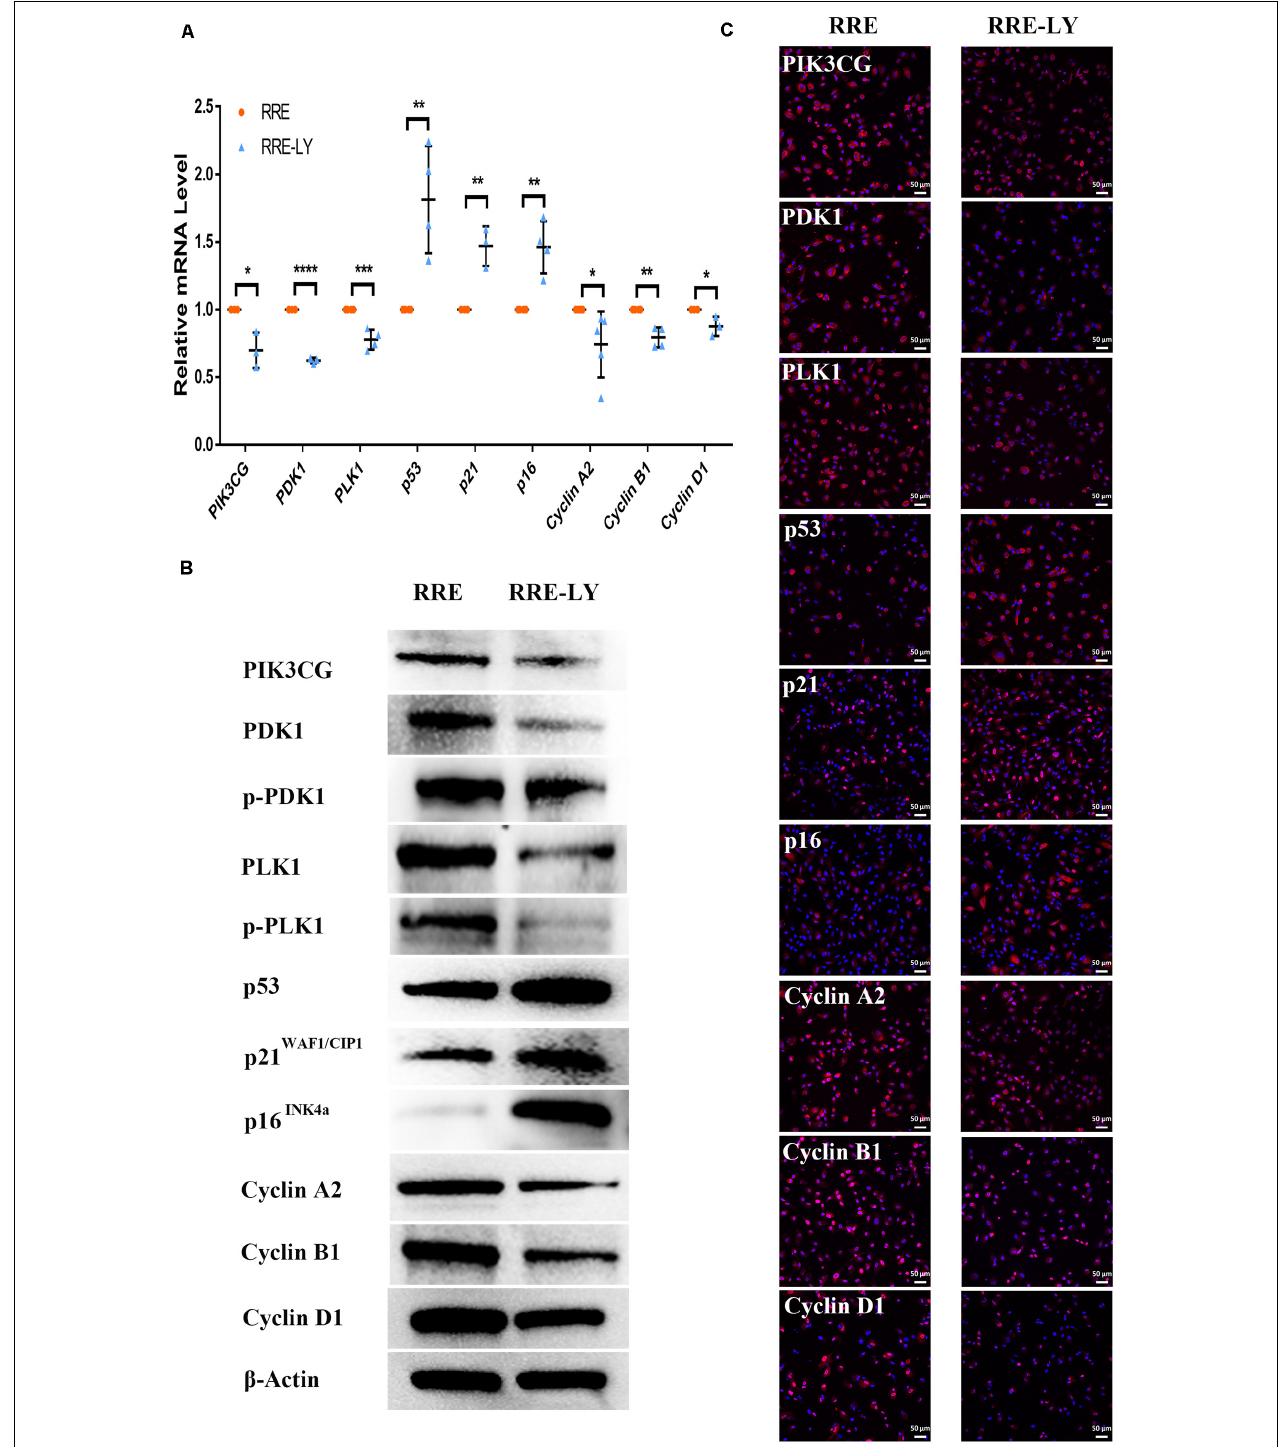
FIGURE 12 | Inhibition of the PI3K pathway upregulated senescence-related positive markers and downregulated senescence-related negative markers in ESCs-cocultured replicative senescent RPE cells. (A) Expression of the PI3K pathway and cellular senescence-related markers in the RRE and RRE-LY groups, as assessed by RT-qPCR ( n ≥ 3 biological repeats). (B) Results for the PI3K pathway and cellular senescence-related markers in the RRE and RRE-LY groups as determined by western blotting. β -Actin was used as the internal reference. (C) The expression levels of the PI3K pathway and cellular senescence-related markers in the RRE and RRE-LY groups as determined by immunofluorescent staining. Scale bar, 50 µ m. Data are presented as the mean ± SD. ∗ P < 0.05; ∗∗ P < 0.01; ∗∗∗ P < 0.001; ∗∗∗∗ P < 0.0001. RRE-LY: RPE cells from passages 8 to 10 cocultured with ESCs and treated with 10 µ M LY294002.